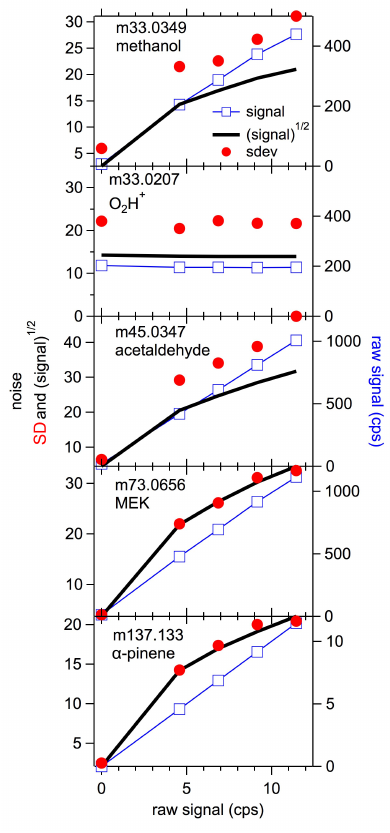
Figure 5. Signal, (signal) 1 / 2 , and standard deviation (SD) of the signal (noise) during a typical PTR-TOF calibration measurement for some selected masses.